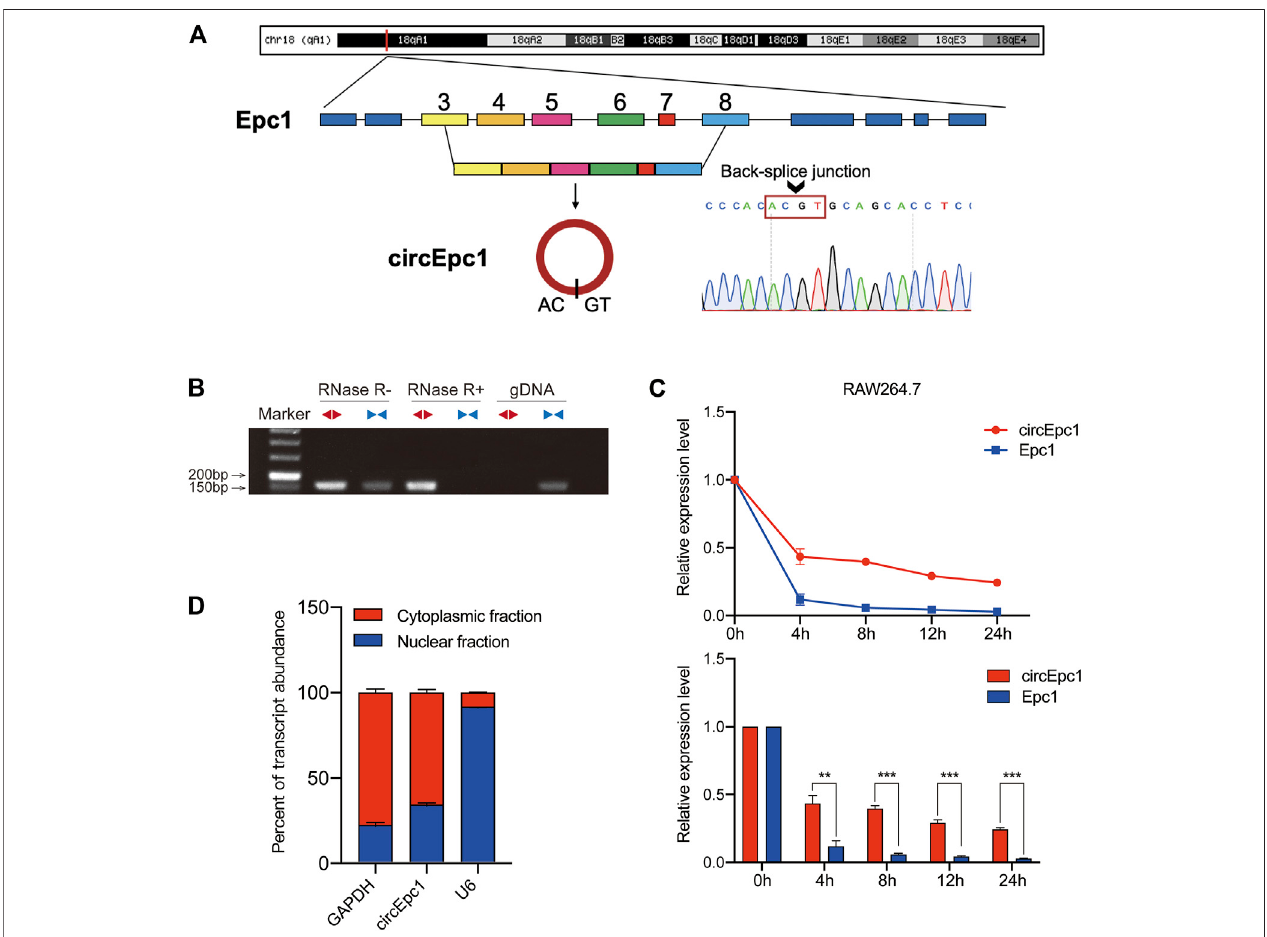
FIGURE 2 | Characterization of circEpc1 in RT-treated RAW264.7 cells. (A) Genomic loci of circEpc1 gene. circEpc1 is produced at the Epc1 gene (ID: 13,831) locus containing exons 3 – 8. The back-splice junction of circEpc1 was identi fi ed by Sanger sequencing. (B) RT-PCR analysis for circEpc1 and its linear isoform Epc1 in cDNA and gDNA in the presence or absence of RNase R supplementation from RAW264.7 cells using divergent and convergent primers. (C) qRT-PCR for the abundance of circEpc1 and Epc1 in RAW264.7 cells treated with Actinomycin D at the indicated time point. (D) Levels of circEpc1 in the nuclear and cytoplasmic fractions of RAW264.7 cells. Data represent the mean ± SD from three representative experiments (* p < 0.05, ** p < 0.01, *** p < 0.001).